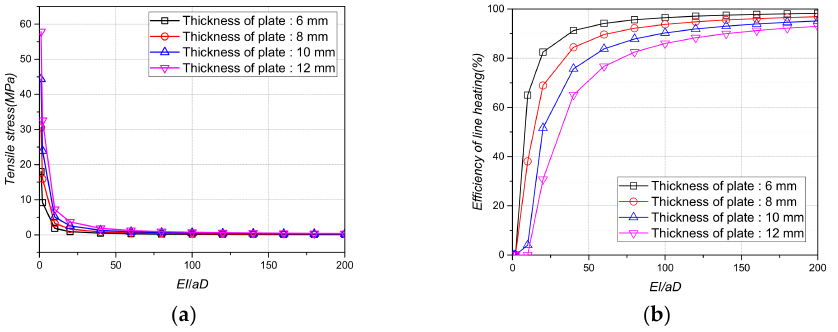
Figure 13. Tensile stress and line heating efficiency by stiffness ratio of plate and beam according to the thickness of the plate. ( a ) Tensile stress by thickness of the plate; ( b ) Line heating efficiency by thickness of the